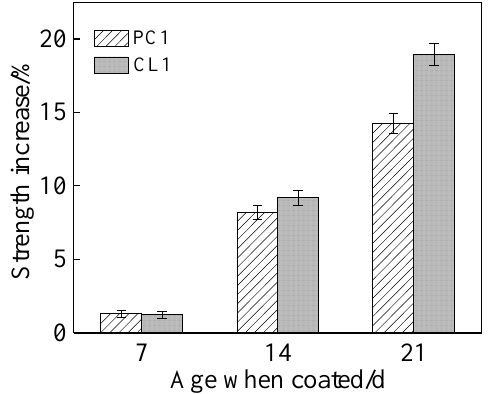
Figure 3. The rate of compressive strength in coated specimens.